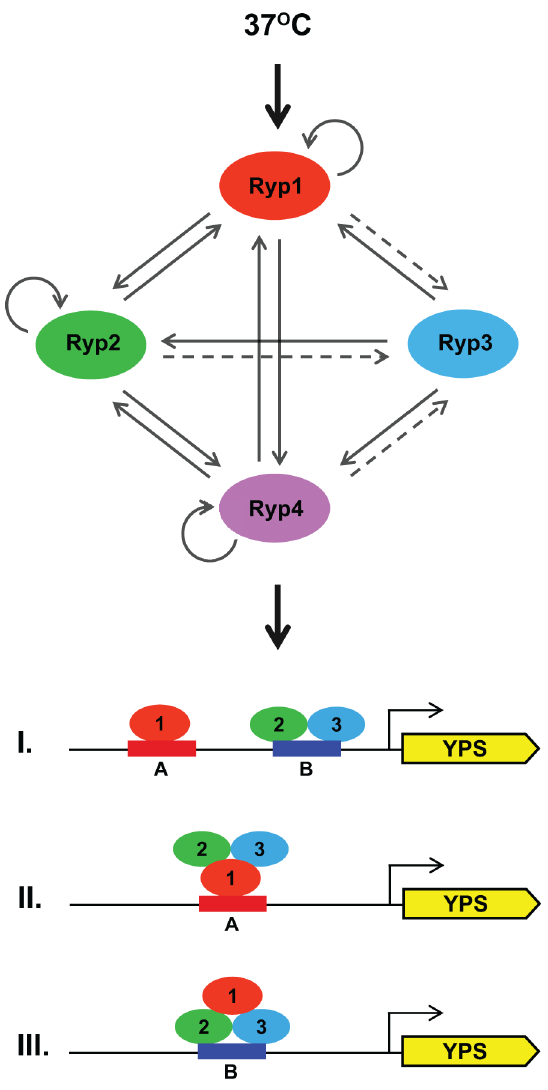
Figure 8. Ryp proteins are involved in a temperature-respon- sive complex transcriptional network. A model for the tempera- ture-responsive Ryp network is shown. ChIP-chip interactions are depicted by solid arrows and indirect regulation is depicted by a dashed arrow. All four Ryp proteins are expressed at increased levels at 37 u C, require each of the others for their expression, and associate with the promoter regions of RYP1 , RYP2 , and RYP4 . Even though none of the Ryp proteins associate with RYP3 promoter, RYP3 expression levels depend on the other Ryp proteins. De novo motif finding approaches and in vivo transcriptional activation assays reveal that Ryp1 is necessary and sufficient to drive gene expression using Motif A, and Ryp2-Ryp3 co-expression is necessary and sufficient to drive gene expression using Motif B. We hypothesize that YPS gene expression in response to growth at host temperature can be achieved through many possible combinations of motifs and Ryp factor association. Three such scenarios are